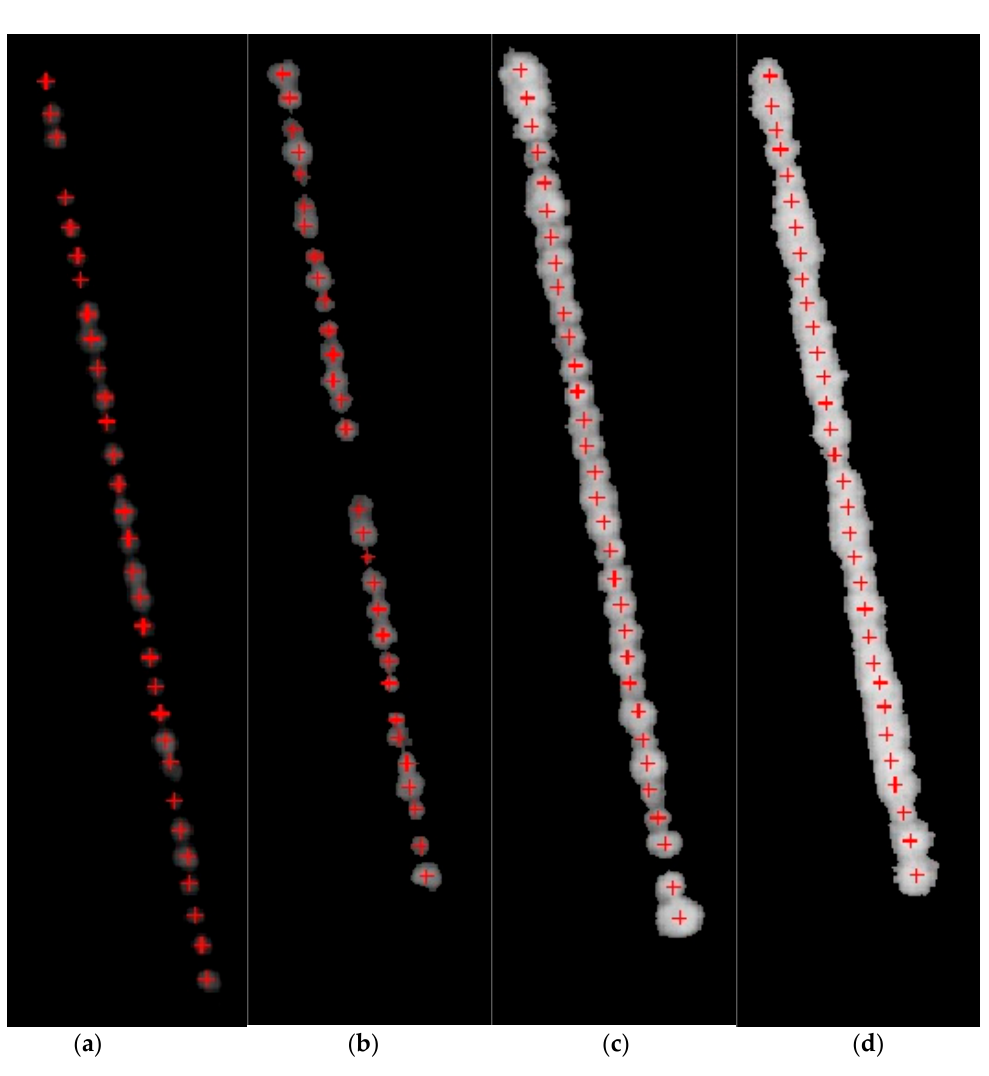
Figure 9. Distribution of image pixels with labelling of center point, center row and horizontal distances from center point to the horizontal extremes.